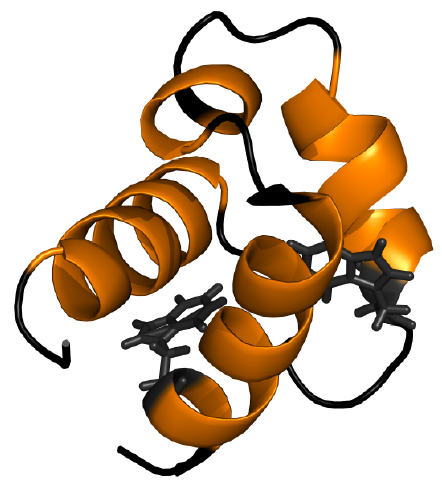
Figure 1. Ribbon representation of the structure of the URN1-FF domain. Tryptophan residues are shown in black. The Protein Data Bank accession code for the structure is 2JUC. This figure was prepared with